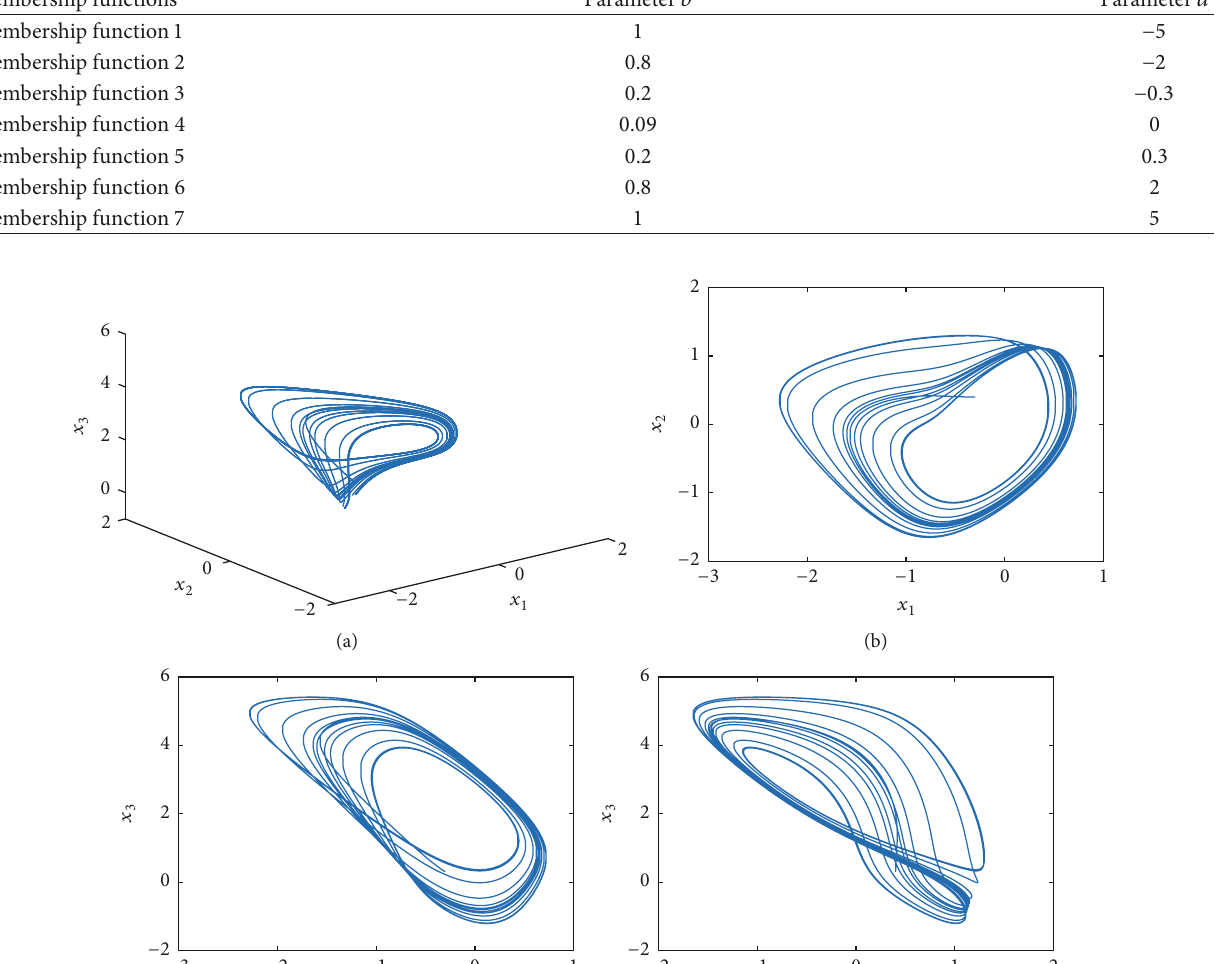
2 /2𝑏 2 defined as 𝑒 −(𝑒 𝑖 (𝑡)−𝑎) , are given in Table 1. These